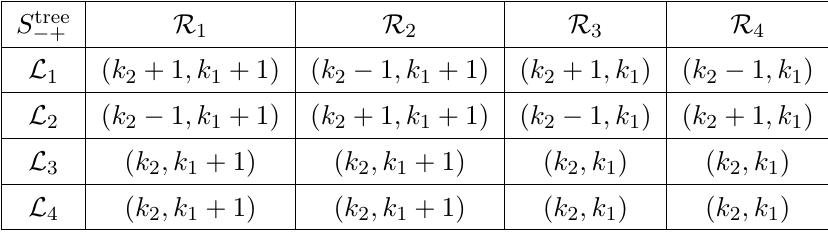
Table 6 . ( k L ; k R ) in all regions for the con(cid:12)guration S (cid:0) + .